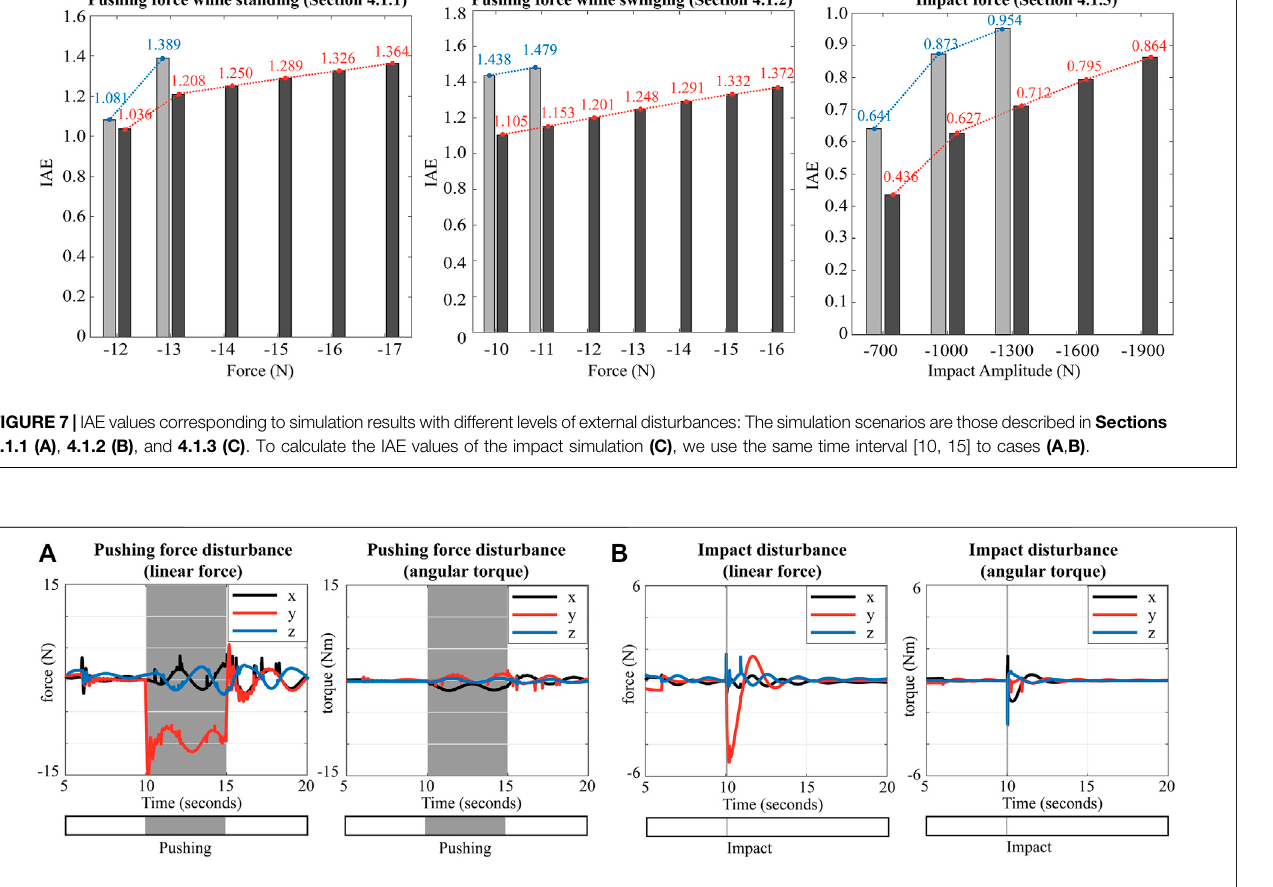
FIGURE8| EstimationofunknownexternalforcesusingthecontactforceformulaprovidedbyWBLC: (A) Pushingforcedisturbance( − 12 Nintheydirection), (B) Impact force disturbance ( − 700 N in the y direction).